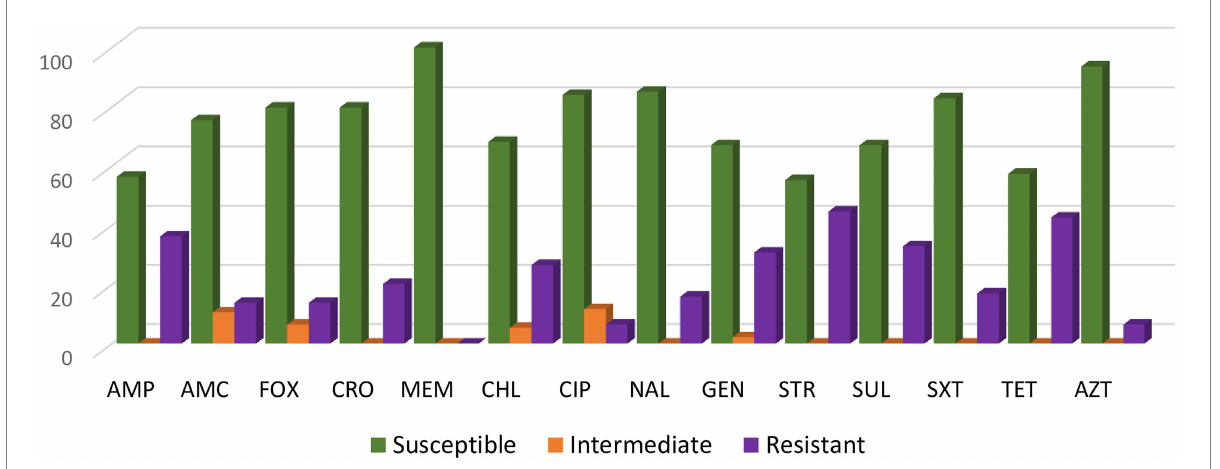
FIGURE 1 Antimicrobial resistance rates of the 94 Salmonella Senftenberg isolates. For ciprofloxacin (CIP) isolates categorized as intermediate (MIC 0.12 to 0.5 μg/mL) or resistant (MIC ≥ 1 μg/mL) were defined as having decreased susceptibility to CIP with a MIC ≥ 0.12 μg/mL.